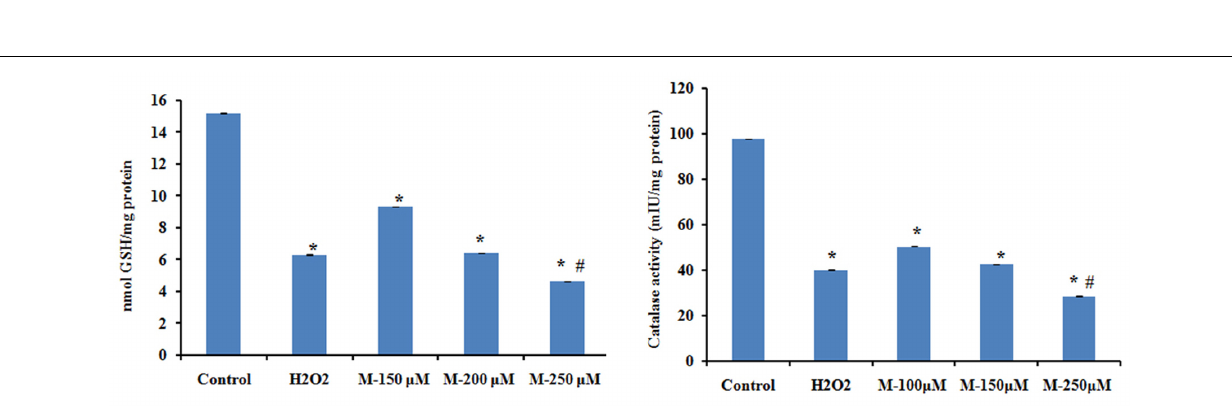
Frontiers in Pharmacology |